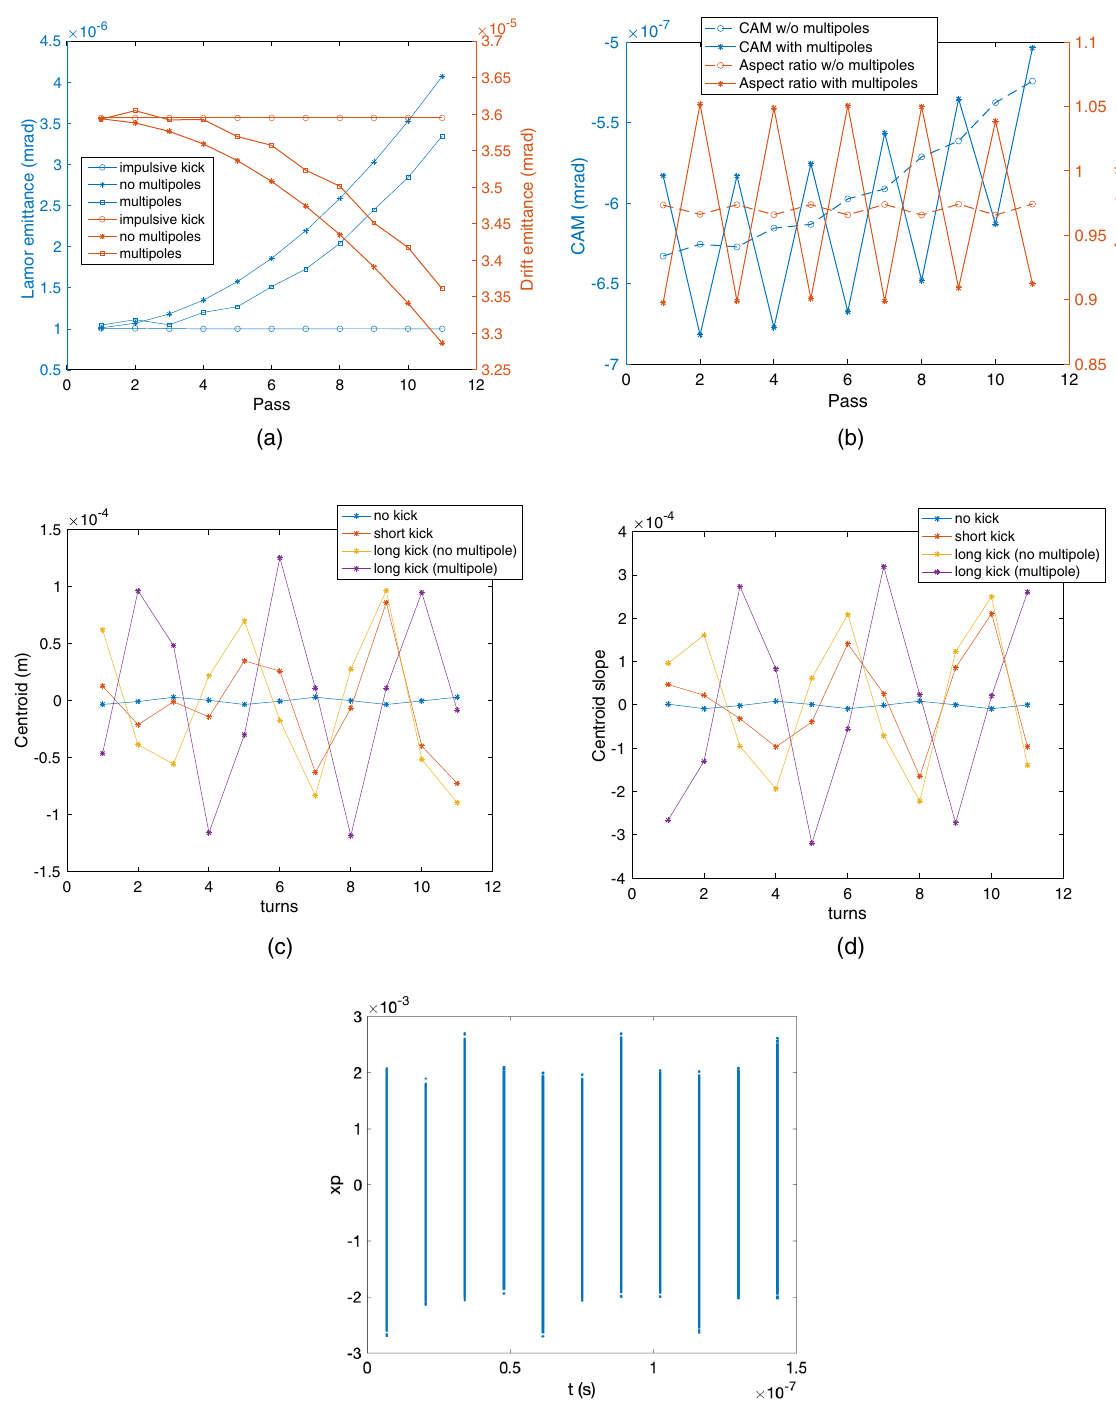
FIG. 16. Evolution of the beam parameters over 11 turns with extended kicks. (a) Eigenemittance evolution. (b) Evolution of CAM and aspect ratio. (c) Centroid evolution. (d) Slope of centroid evolution. (e) The evolution of the angular distribution with an extended kick and